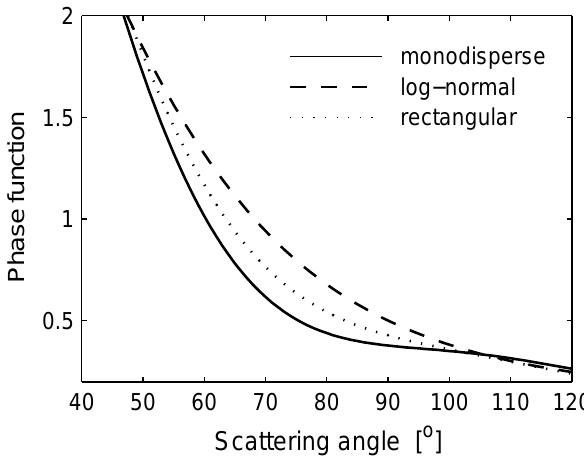
Fig. 6. Ratios in the scattering efficiency at Lyman- α , 220nm and 450nm. The ratios apply to a scattering angle of 90 ◦ and are nor- malized to Rayleigh scattering of the smallest particles. Significant deviations from Rayleigh scattering start at particle radii around 25nm when measurements at Lyman- α are